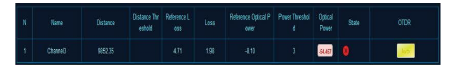
Figure 15: Link channel 3 failure monitoring diagram assisted by AI module.